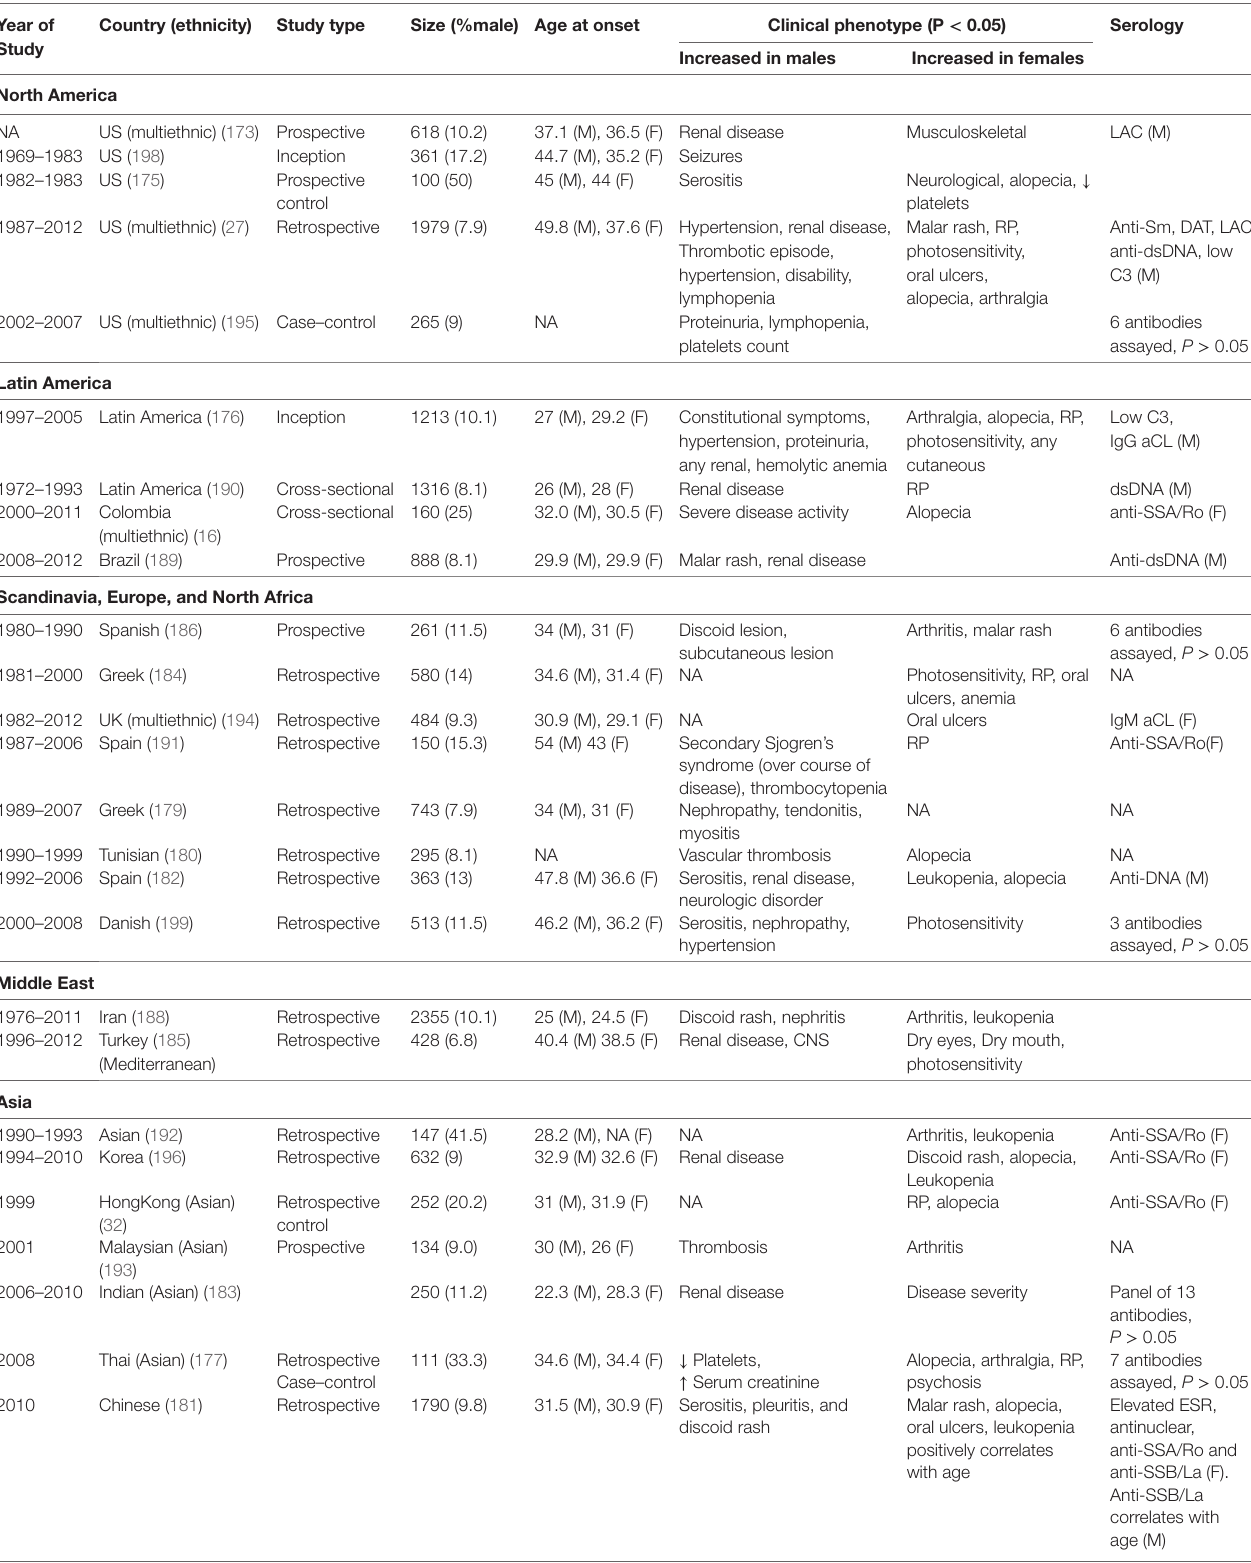
taBLe 4 | Comparative studies of male and female lupus: main clinical and demographic findings, adapted with modifications from Ref. (1, 8,